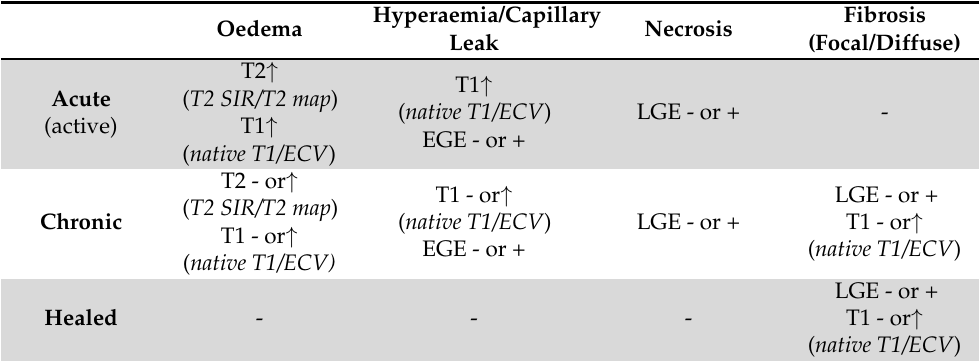
Table 2. CMR features in myocarditis according to disease stage and pathologic